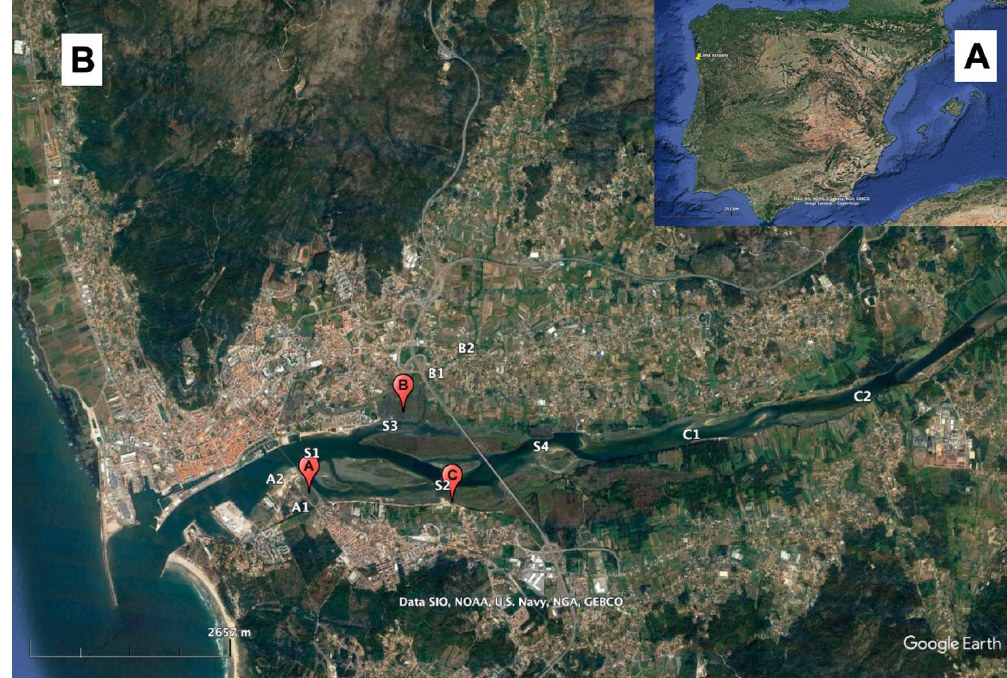
Figure 1. ( A ) Localization of the Lima estuary within the Iberian Peninsula and ( B ) the Lima estuary with sampling locations for vegetated and non-vegetated sediments: Sra das Areias (site A) and Salinas (site B), both colonized by J. maritimus and P. australis; and Canoagem (site C) colonized by J. maritimus and S. maritima and locations for water collection: upstream the saltmarsh (C1 and C2), within the saltmarsh (S1, S2, S3, and S4), downstream the saltmarsh (A1) and possible pollutants sources (A2 (open water reservoir); B1 and B2 (freshwater stream)).